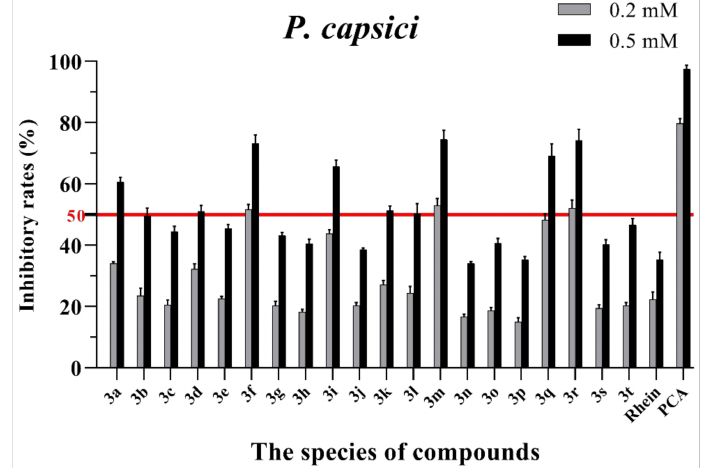
Figure 6. Mycelial growth % inhibition of chemicals against P. capsici . The bold red line is the identity line with the inhibition rate of